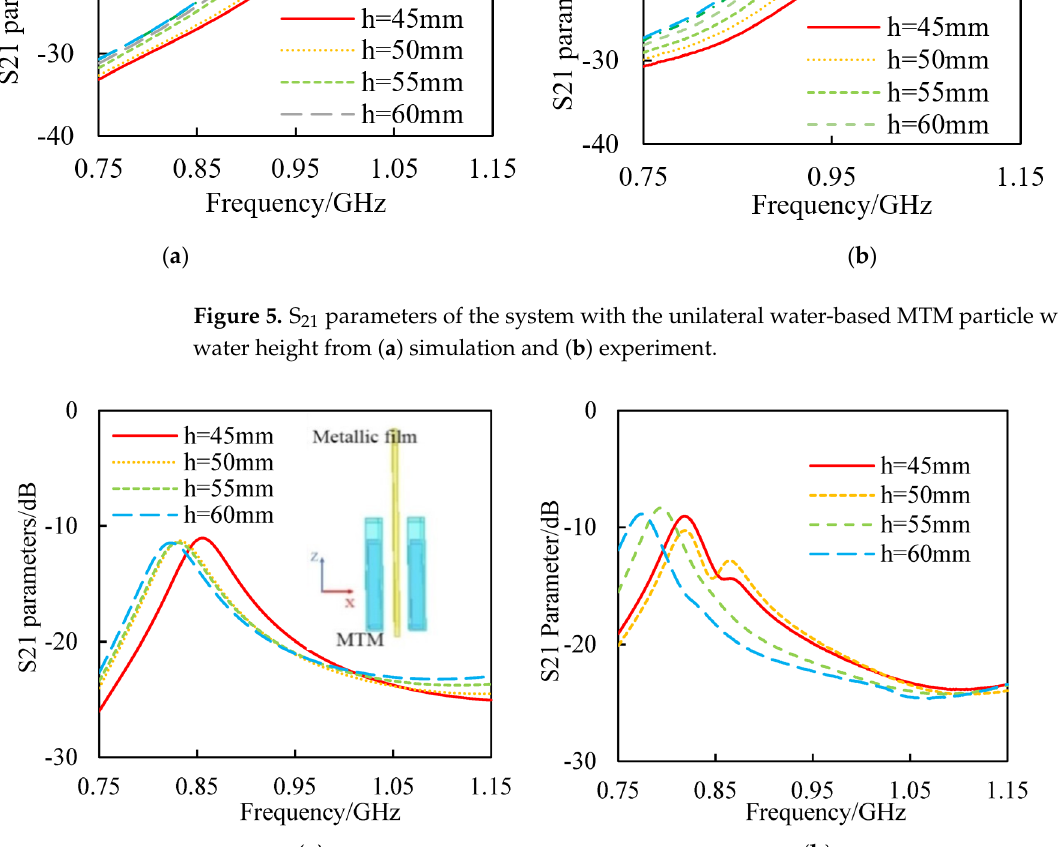
Figure 6. S 21 parameters with the bilaterally symmetric MTM particle with different water height from ( a ) simulation, ( b ) experiment.